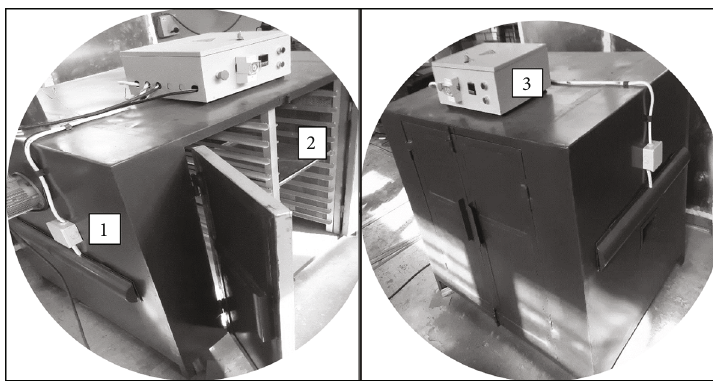
Figure 1: Fabricated mechanical dryer: (1) cabinet body, (2) drying chamber, and (3) control